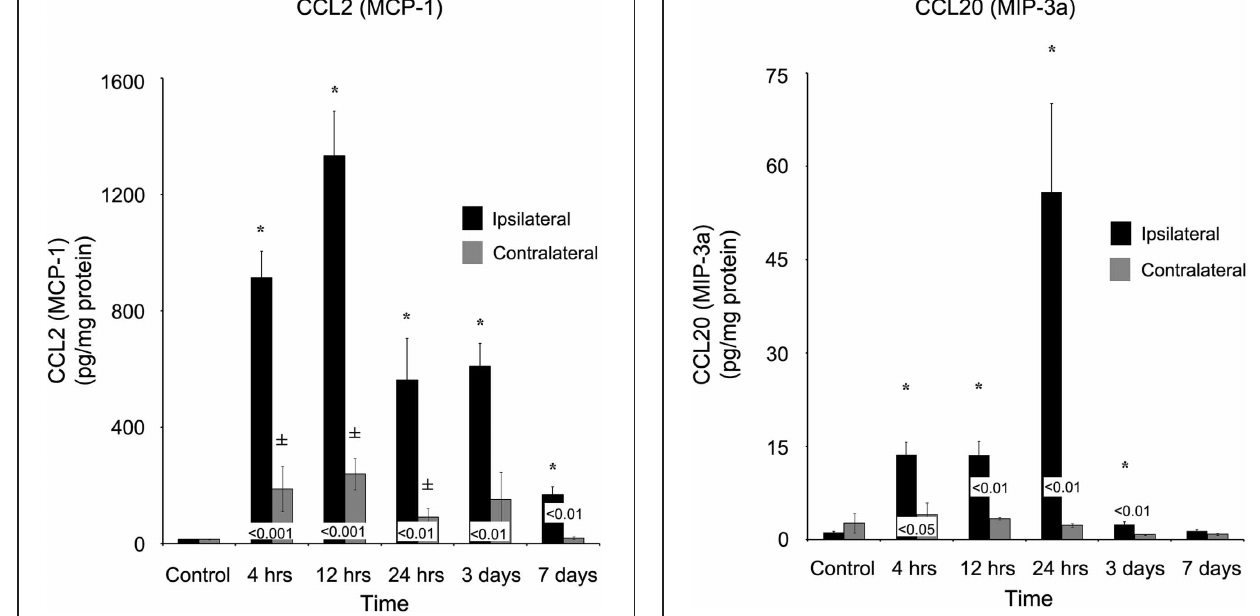
FIGURE 6 | CCL2 concentrations increase in both the ipsilateral and contralateral cortex following a controlled cortical impact. Within four hours of a brain injury, CCL2 increases ( p < 0 . 05) in both the ipsilateral and contralateral cortex in comparison to control. In comparison to both control and contralateral tissue, the ipsilateral hemisphere continued to express elevated ( p < 0 . 05) concentrations for seven days. In contrast, the contralateral cortex only demonstrated an elevated expression in comparison to control ( p < 0 . 05) at 4, 12, and 24 hours, returning to normal levels by three days after injury. All values are mean ± SEM, n = 5. ∗ At each time point noted, ipsilateral differs from control tissue, p < 0 . 05. ± At each time point noted, contralateral differs from control tissue, p < 0 . 05. Differences between the ipsilateral and contralateral cortices are denoted by placing the appropriate p -value above the two bars.